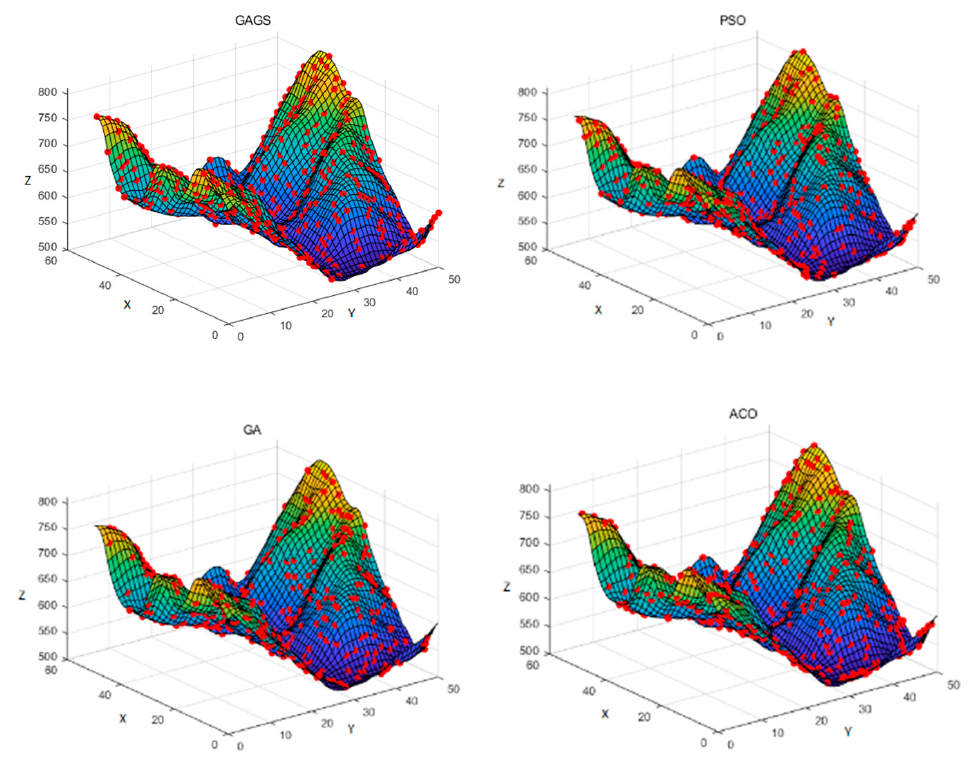
Figure 13. Node deployment results after reducing the coverage threshold.